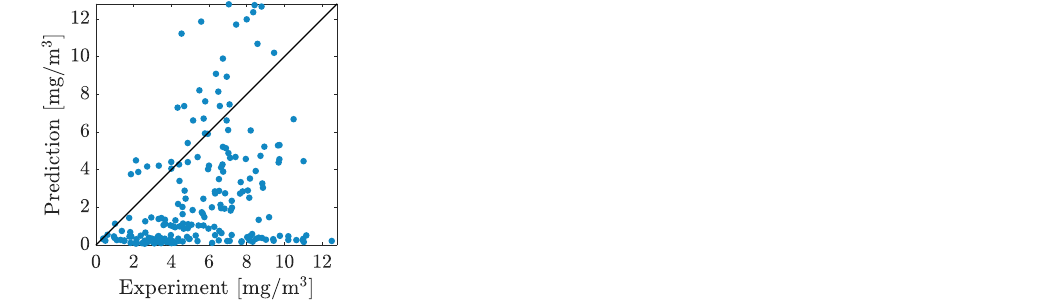
Figure 12. Comparison of the Physics-based GT-power model prediction against experimental data (good accuracy is when the data follows the diagonal line).